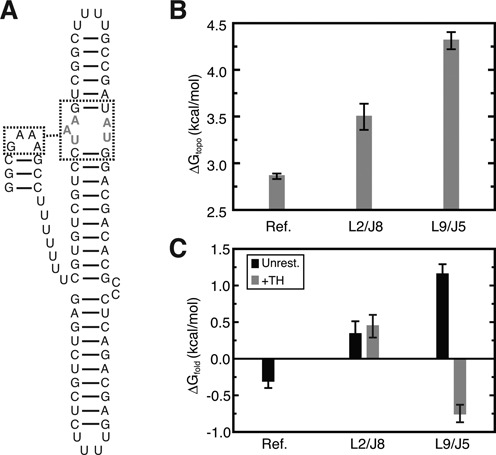
Comparison between the ΔGtopo for an isolated TL/TLR interaction and Azoarcus TL/TLR interactions. (A) Secondary structure of the simulated reference system (49). TLR residues that were restrained to the native receptor conformation are drawn in gray lettering. (B) ΔGtopo for the reference system and L9/J5 and L2/J8 interactions. Values for the reference represent the mean and standard deviation of three replicates. (C) ΔGfold for the reference measured experimentally at 37°C and 1 mM Mg2+ (Figure 3 in (49)), and calculated for L9/J5 and L2/J8 via Equation (3) from unrestrained simulations (black). ΔGfold of the TL/TLRs conditional on TH folding, estimated from TH-restrained simulations, is shown in gray bars.